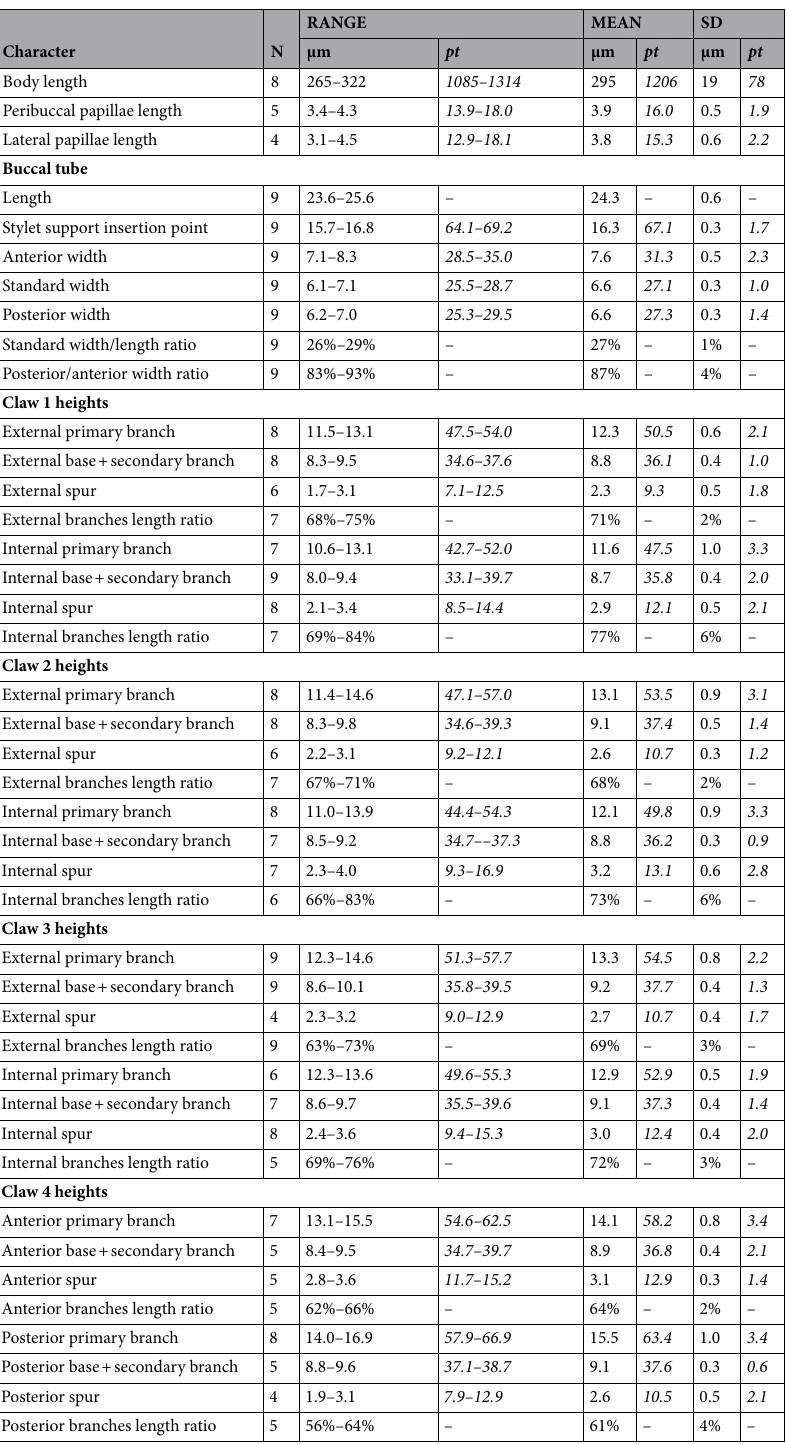
Table 5. Measurements (in μm) and the pt values of selected morphological structures of 9 hatchlings of Milnesium decorum sp. nov. from Portugal, PT.010, mounted in Hoyer’s medium. All available specimens were